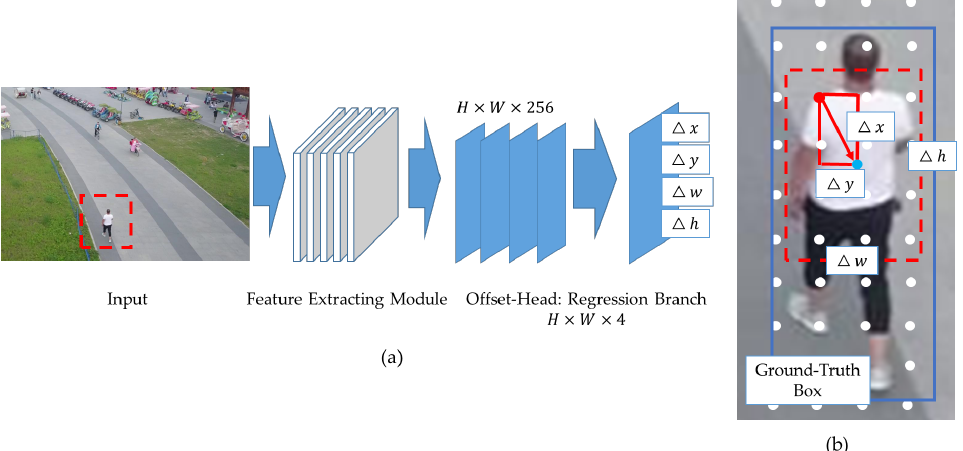
Figure 3. The details of detector head. ( a ) The detailed structure of Offset-Head (regression branch), and ( b ) The definition of four